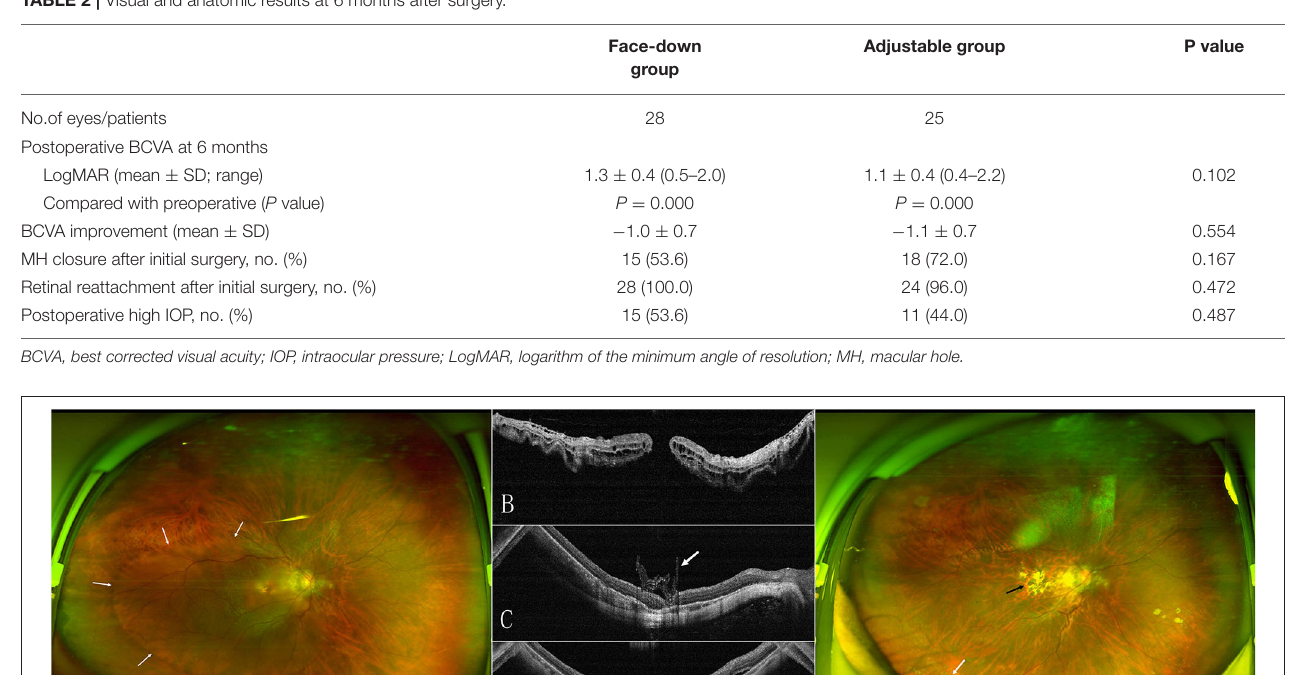
TABLE 2 | Visual and anatomic results at 6 months after surgery.